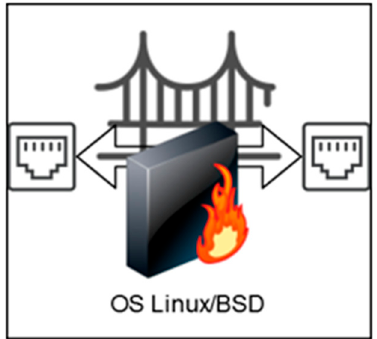
Figure 11. Configuration for transparent bridge for OS Linux.